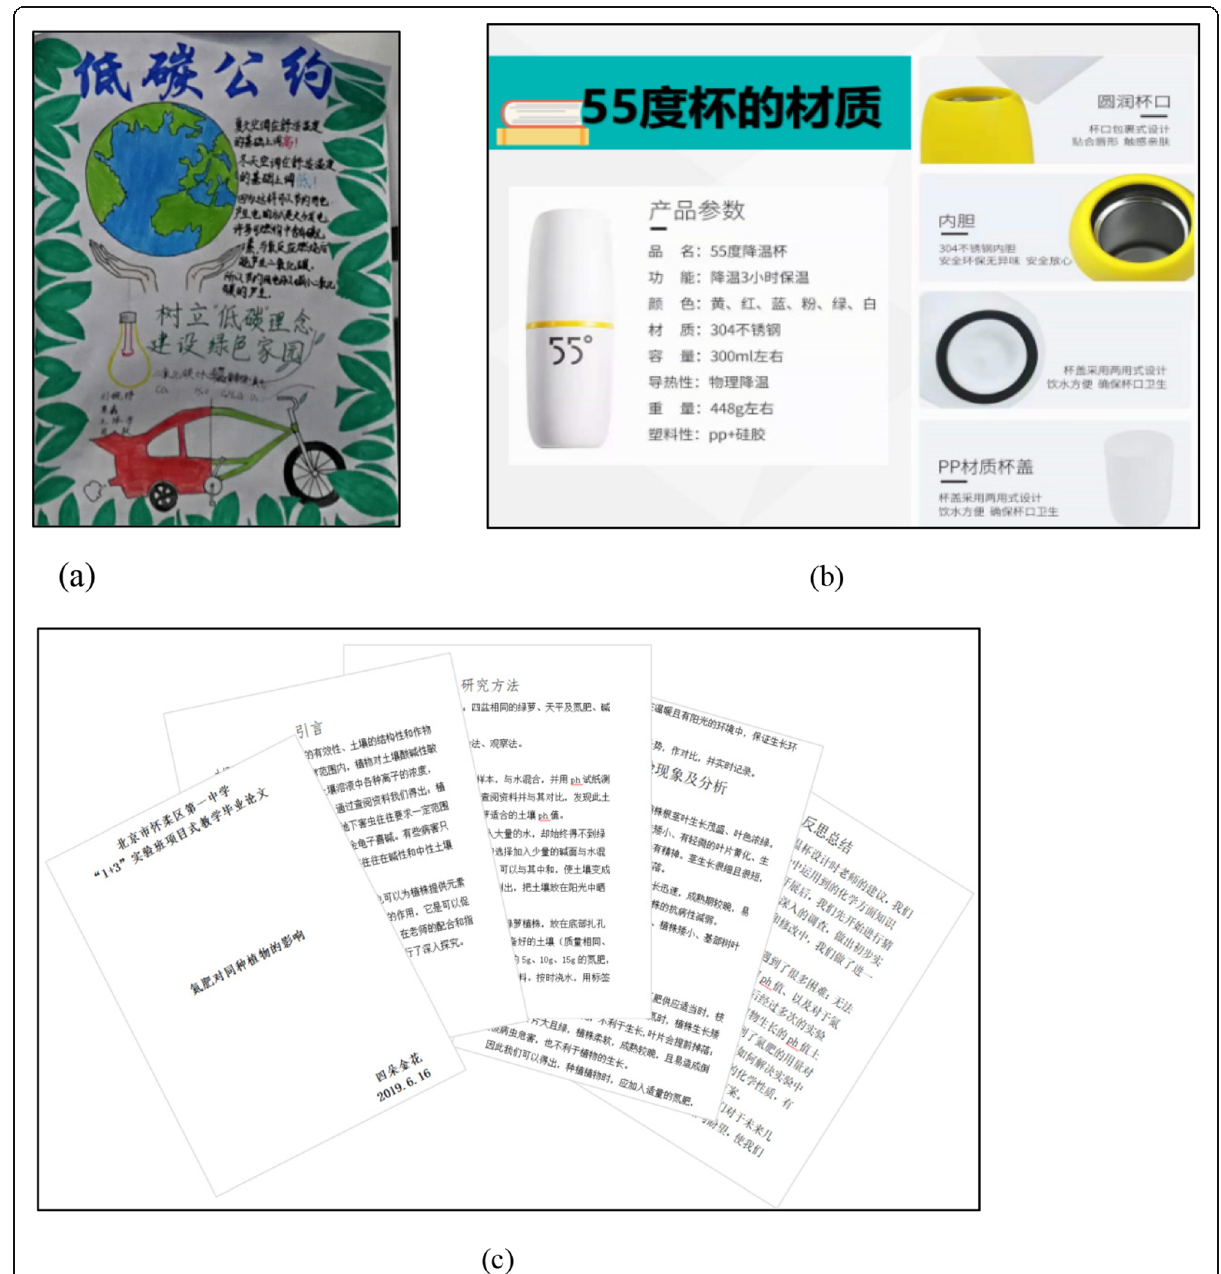
Fig. 3 Sample screenshots from student artifacts: ( a ) Low Carbon Convention Poster, ( b ) PPT screenshot of 55-degree cup introduction and ( c ) Report of Unit